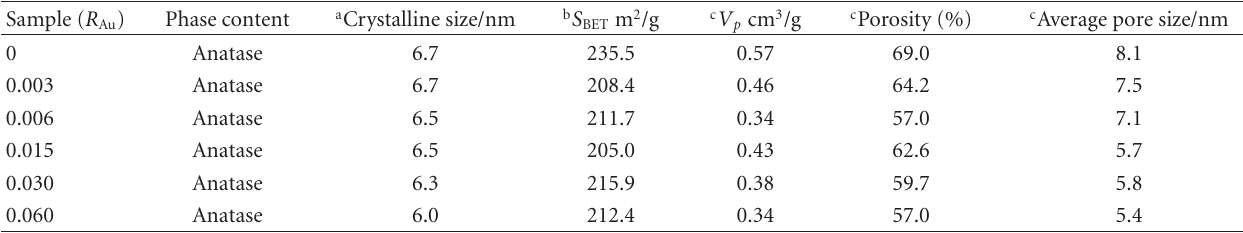
Table 1: E ff ects of R Au on physical properties of the Au-TiO 2 composite powders.